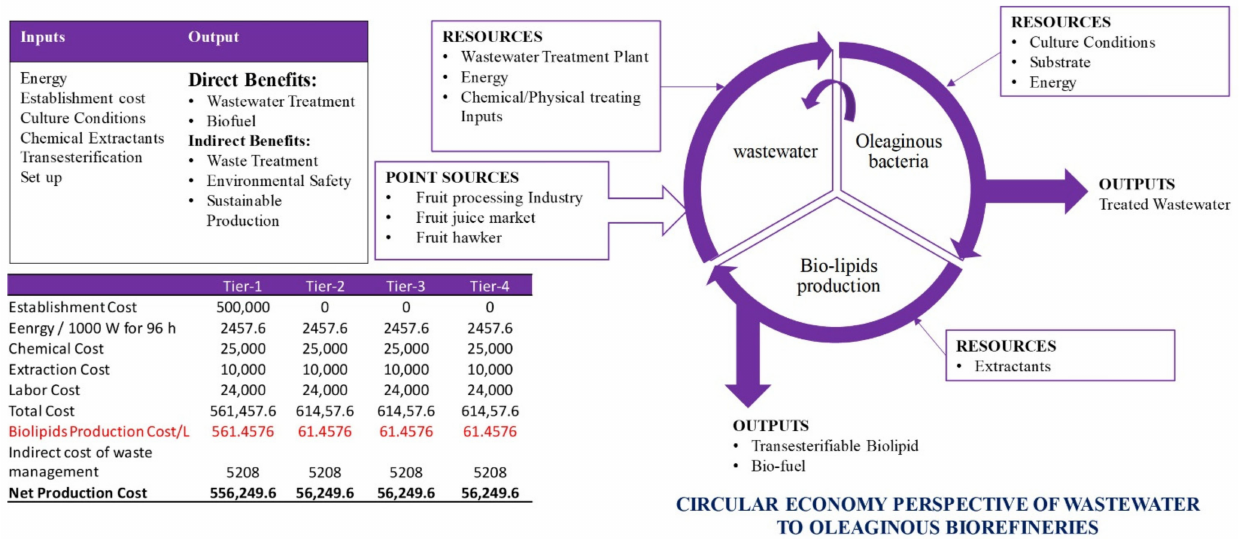
Figure 7. Waste to energy circular economy model using oleaginous bacteria under different tiers of capital and output